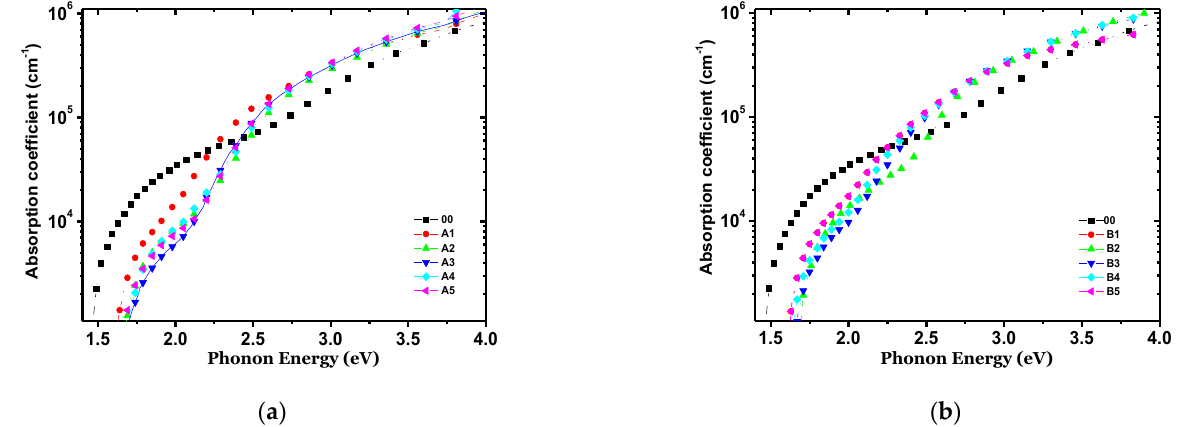
Figure 3. Refractive index vs. wavelength for two series of thin films: ( a ) n-type films with different H 2 and PH 3 contents; ( b ) p-type films with different H 2 and B 2 H 6 contents.